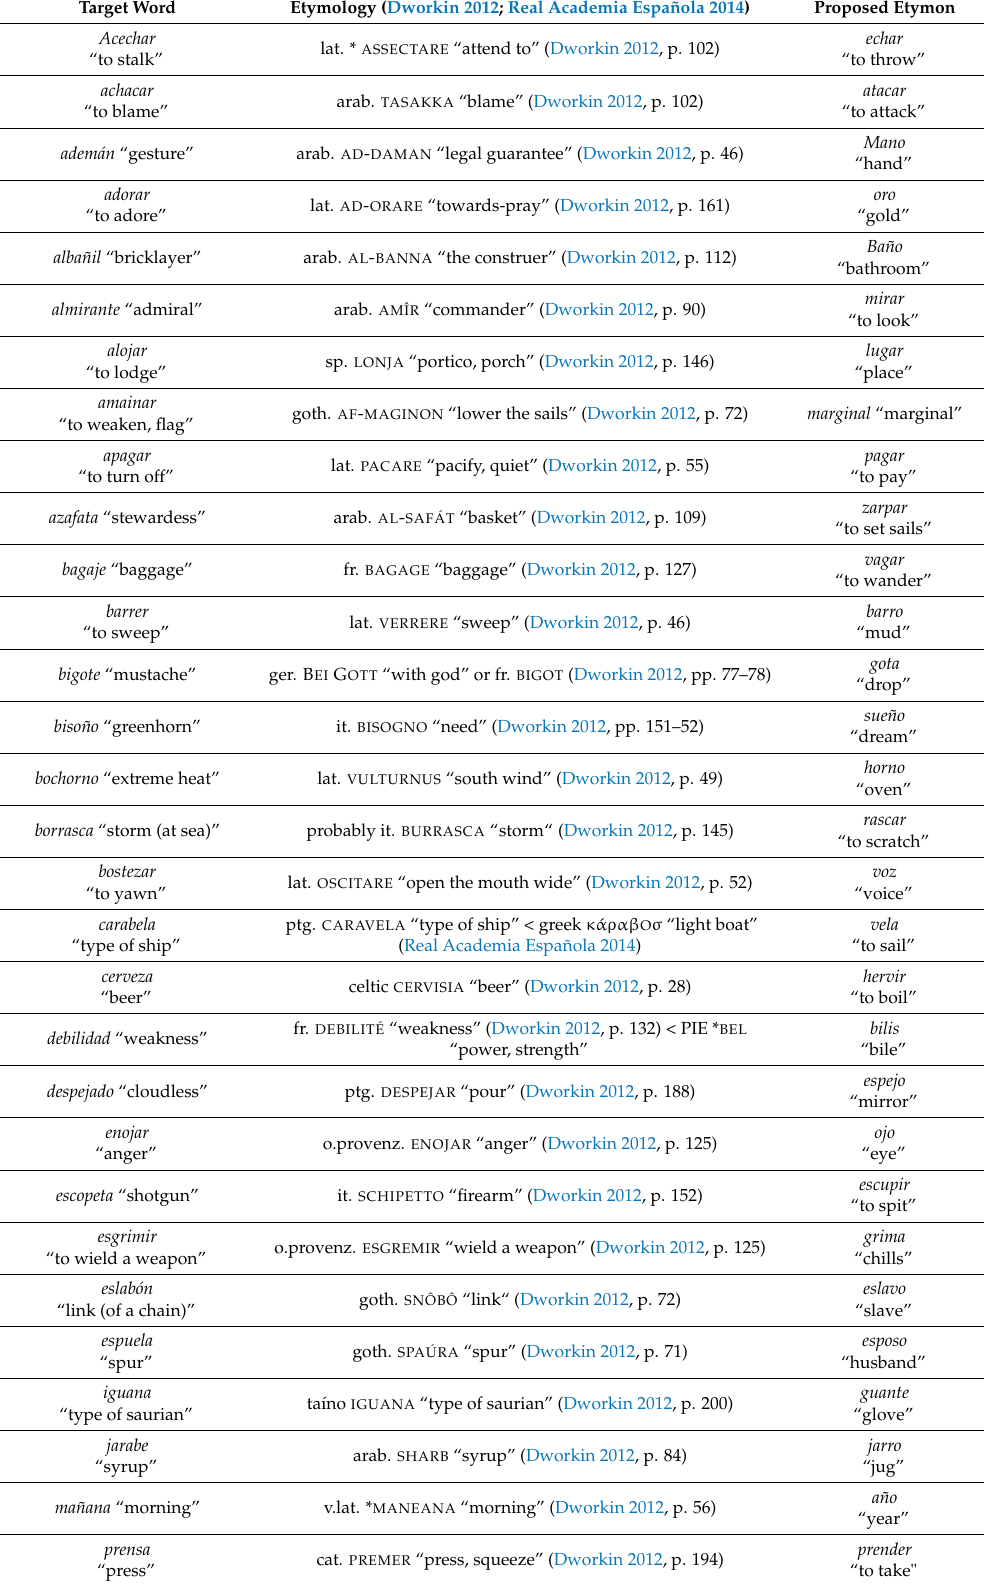
Table A1. Target words and proposed